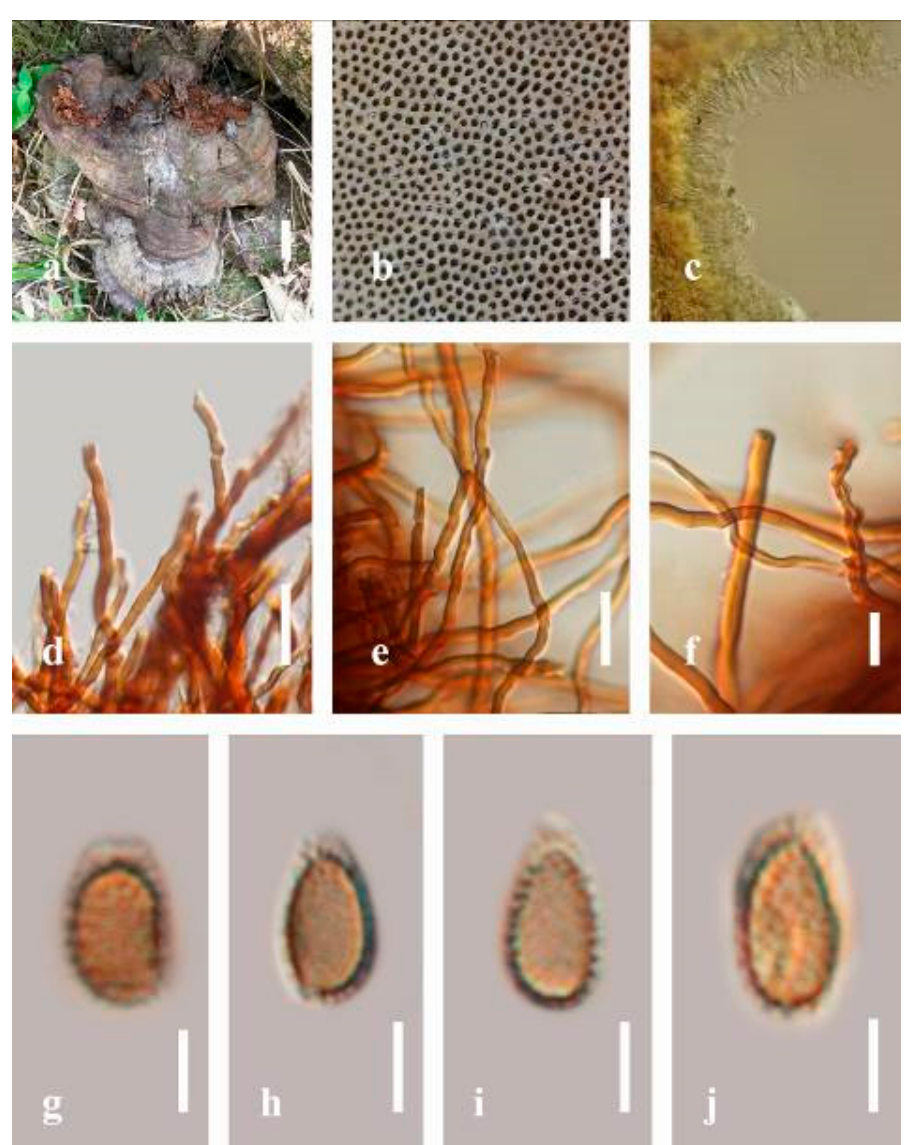
Figure 22. Morphology of Ganoderma adspersum (MFLU 19 ‐ 2178): ( a ) mature basidiomes; ( b ) pores characteristics; ( c ) hyphae of tube layers in KOH; ( d – f ) hyphae of thama in KOH; ( g – j ) basidiospores. Scale bars: ( a ) = 2 cm, ( b ) = 1000 µ m, ( c – f ) = 20 µ m, ( g – j ) = 5 µ m. Ganoderma applanatum (Batsch) G.F. Atk., Annales Mycologici 6: 189 (1908) (Figure 23) Facesoffungi number: FoF 06249